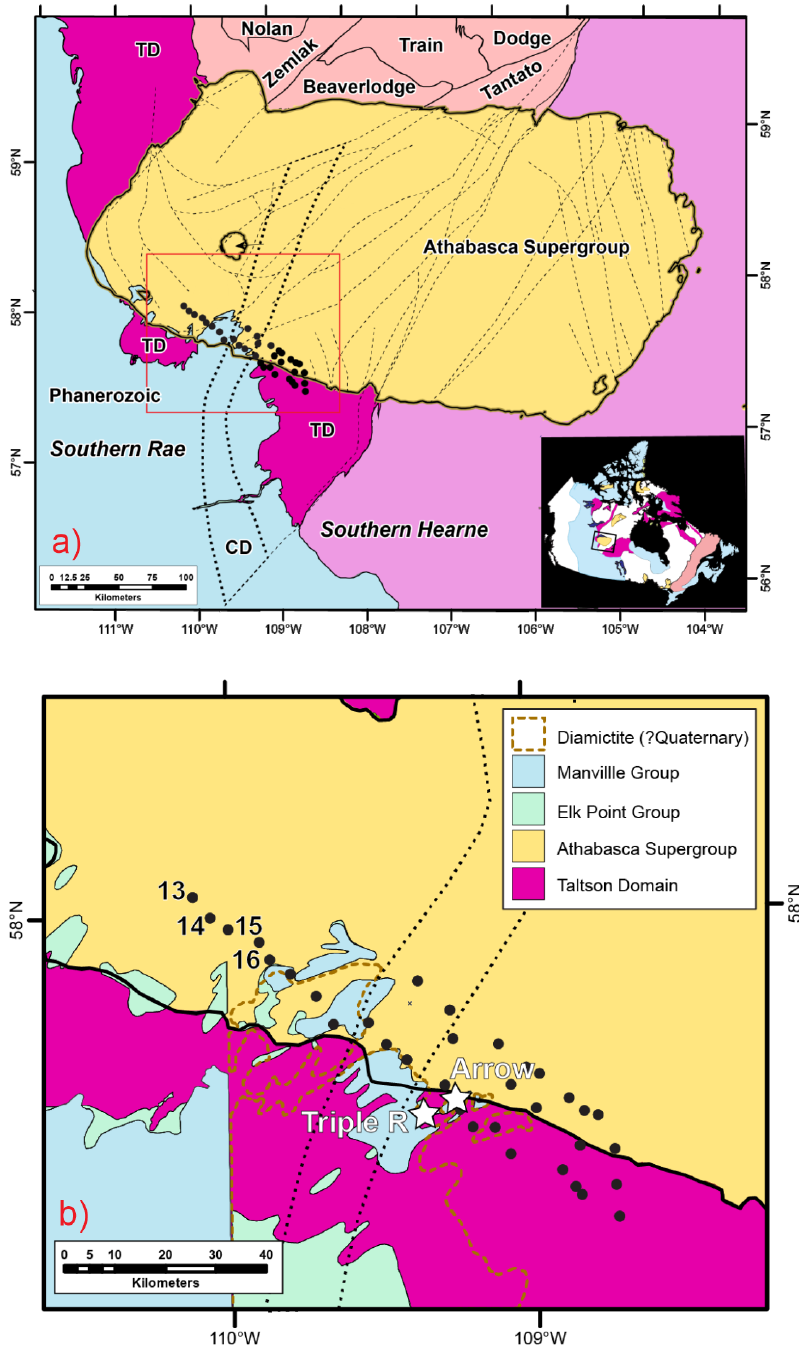
Figure 8. ( a ) Simplified geological map of the Athabasca Basin outlining the location of ( b ) by a red box. Clearwater Domain (CD) is outlined by black dotted line, and the location of structures from Jefferson et al. [35] is plotted as black dashed lines. TD = Taltson Domain; ( b ) geological map of the Patterson Lake corridor MT survey area. Location of MT stations plotted as black dots; location of uranium deposits labeled by white stars (modified from Tschirhart et al.